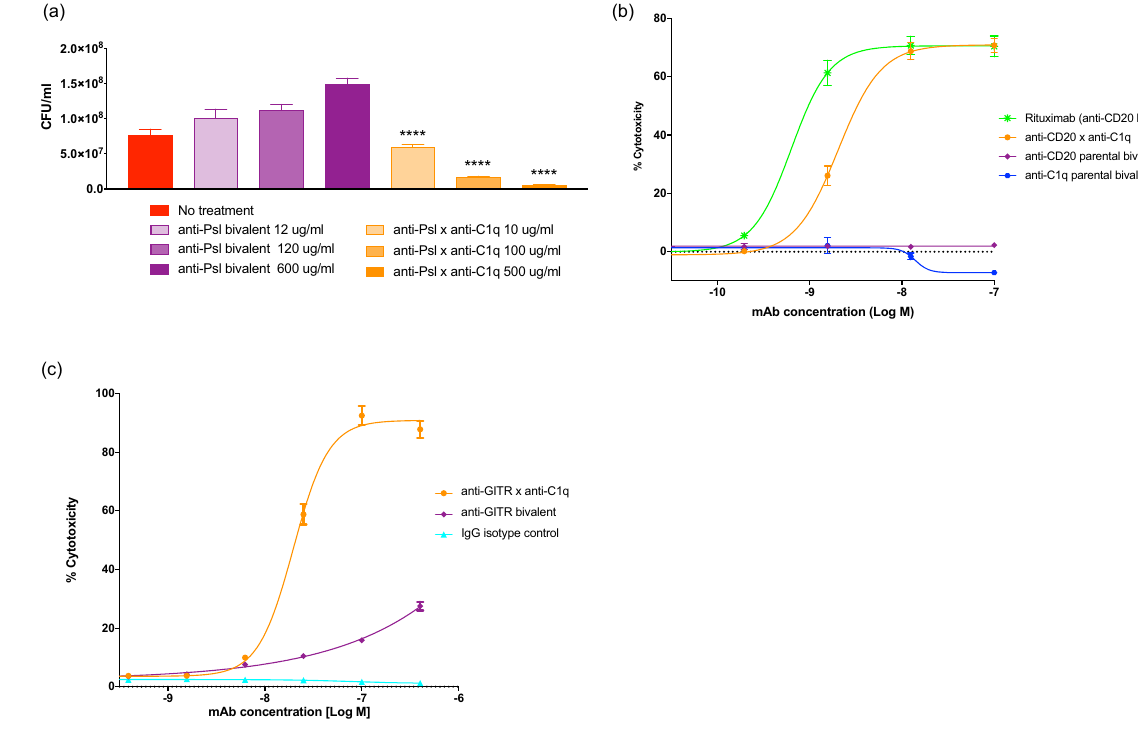
Figure 4. C1q-recruiting bsAbs bind to target cells and mediate cytotoxicity. ( a ) Growth of P . aeruginosa PAO1 in human blood was determined in the presence of the indicated antibodies and in blood or media (TSB) alone. **** P < 0.0001, two-way ANOVA showing bsAb samples significantly different from the corresponding bivalent antibody. Results are plotted as mean with standard deviation. ( b , c ) The ability of antibodies to mediate target cell lysis was measured using CDC assays. Increasing concentrations of the indicated antibodies were incubated with 5% NHS and Raji cells ( b ; human B-cell line) or Jurkat cells expressing human GITR and CD20 ( c ; human T- c ell line) for 2 or 3.5 h respectively. Cell lysis was quantified using the CytoTox-Glo assay which measures the release of proteases from dead cells. Percent cytotoxicity was calculated as the background subtracted experimental signal divided by the background subtracted maximum lysis signal. Results are plotted as mean ± standard